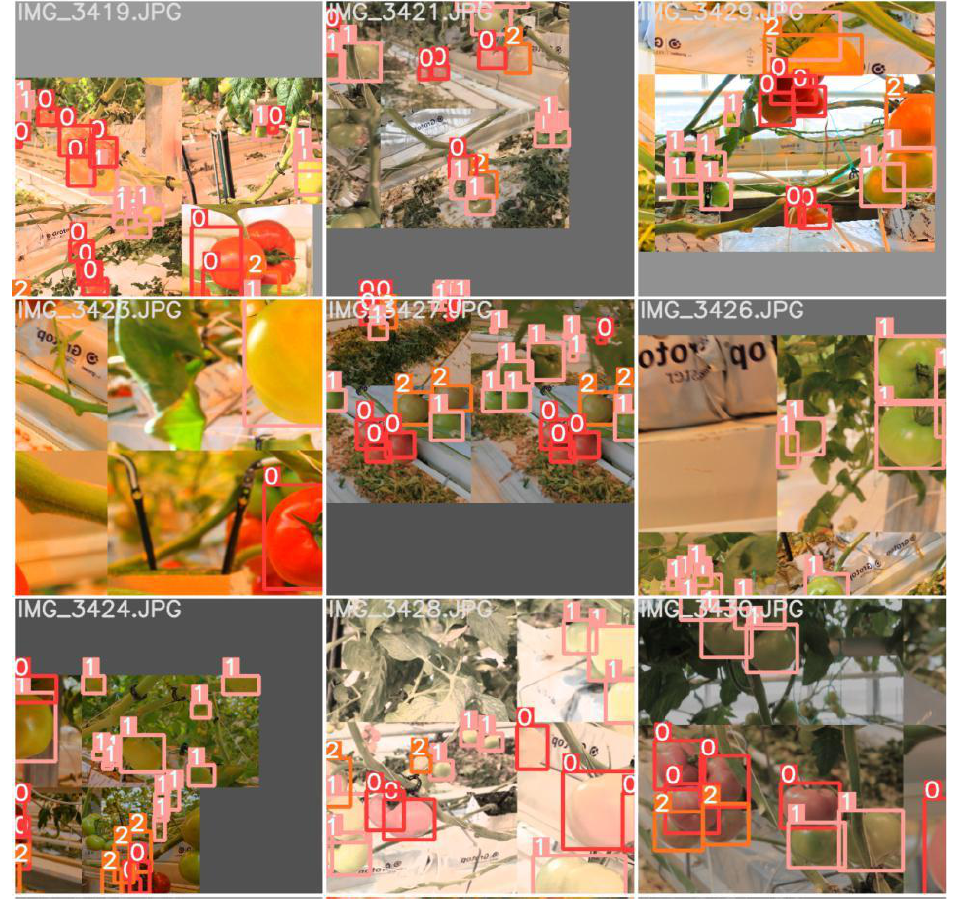
Figure 13. Testing of the tomato recognition in a real environment.